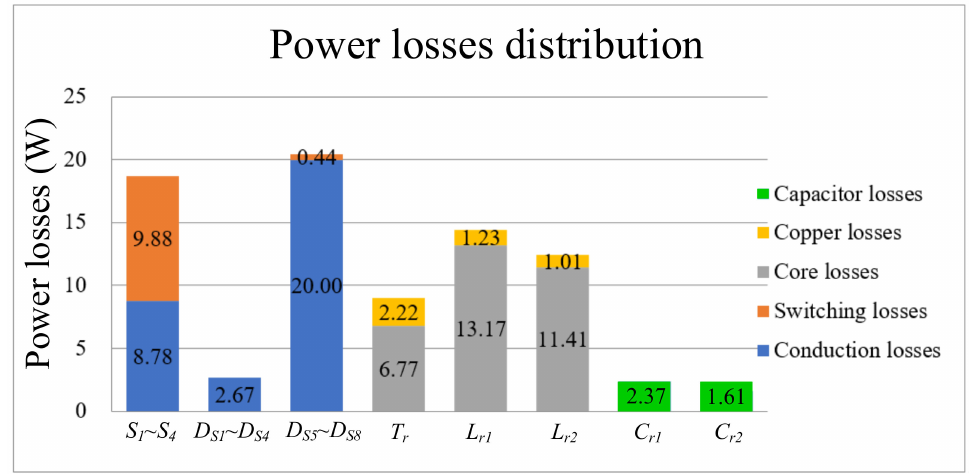
Figure 24. Power losses distribution in the proposed converter operated in the full load condition.